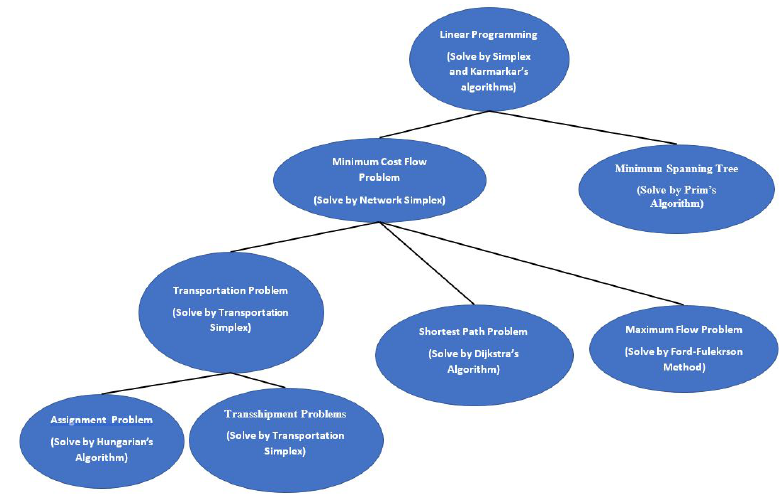
Figure 3. Taxonomy of the relationships of Linear Programs (LPs), network flow programs (NFPs) and their special classical sub-classes